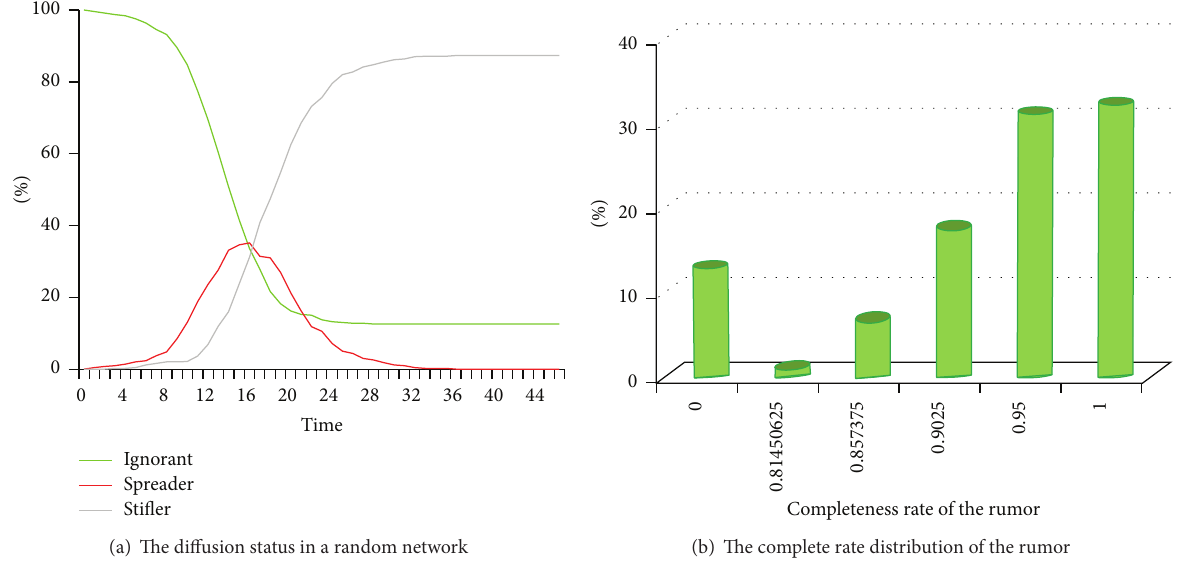
Figure 8: The rumor diffusion status in a random network (average degree of this network is 5).